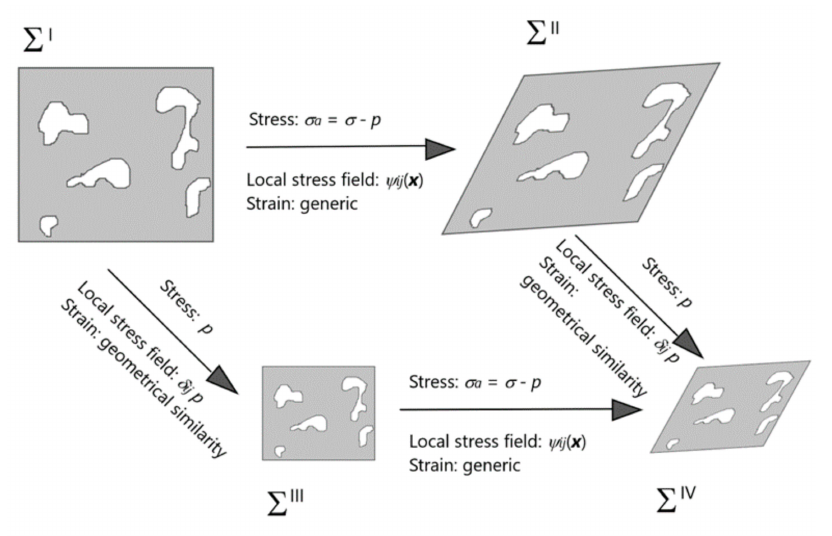
Figure 5. Schematic diagram showing a generic volume of porous aggregate experiencing the stress systems σ a = ( σ − P ) and p . The local stress field ψ ij is a valid solution when the stress σ a is applied over Σ II or all its similar surfaces. The solution associated to a uniform isotropic pressure p is independent from the boundary surface